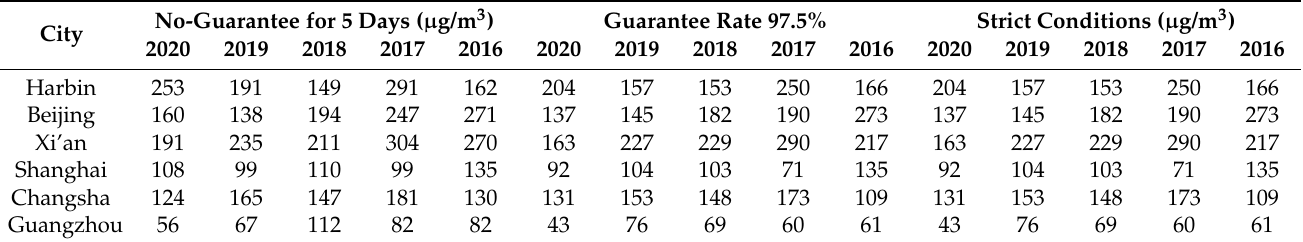
Table 5. Outdoor PM 2.5 design concentrations using three